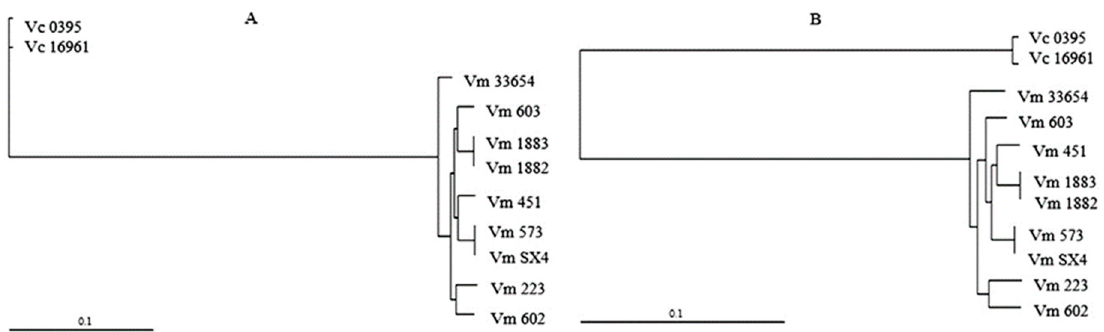
Figure 2. Phylogenetic tree of the core genes of V. mimicus MB451, V. mimicus VM573, V. mimicus SX4, V. mimicus CAIM-602 T , V. mimicus ATCC-33654, V. mimicus VM603, V. mimicus VM223, V. mimicus CAIM-1882, V. mimicus CAIM-1883, and two V. cholerae (Vc O395 and Vc 16961). ( A ): Maximum likelihood (ML) tree of ChI. ( B ): ML tree of ChII.